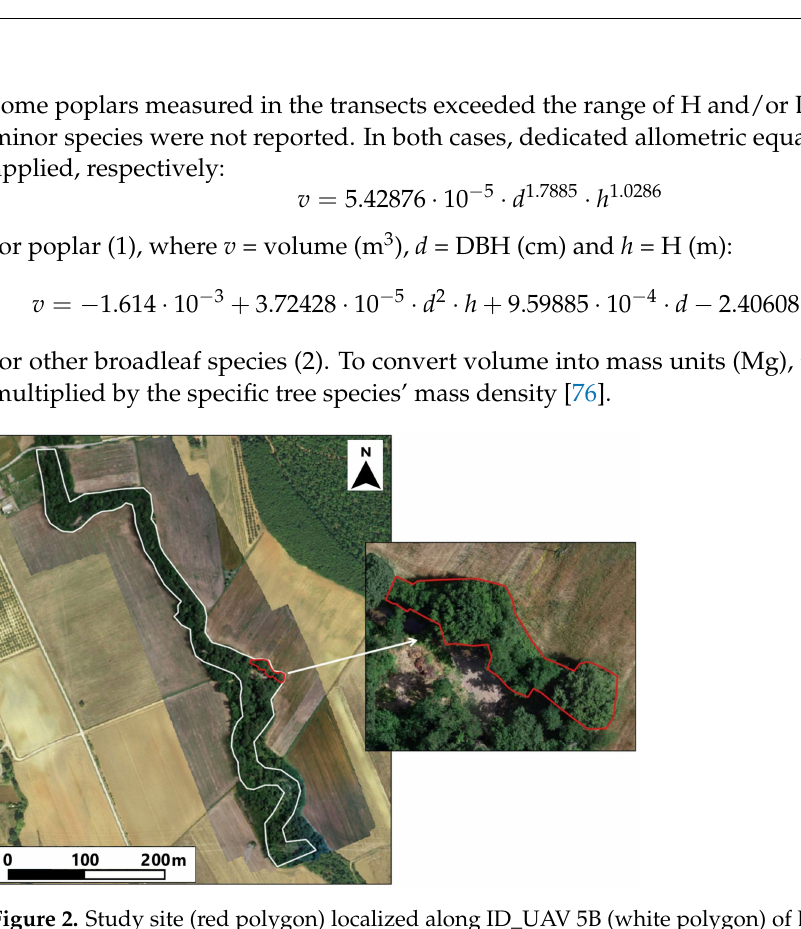
Figure 2. Study site (red polygon) localized along ID_UAV 5B (white polygon) of Bruna River.